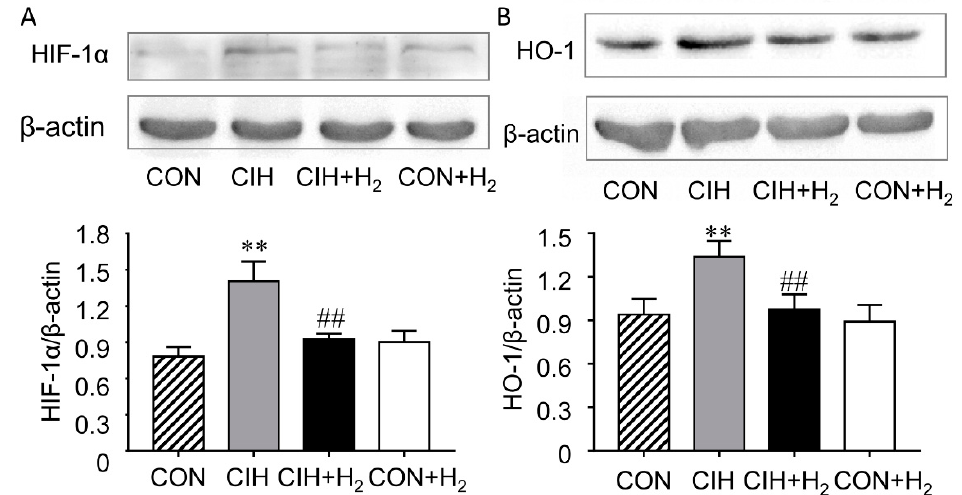
Figure 5. Effect of H 2 on renal HIF-1 α (hypoxia-inducible factor-1 α ) and HO-1 expression. ( A ). H 2 inhibited the increase of HIF-1 α expression. ( B ). H 2 suppressed the increase of HO-1 expression. ** p < 0.01 vs. normoxia group; ## p < 0.01 vs. CIH group.